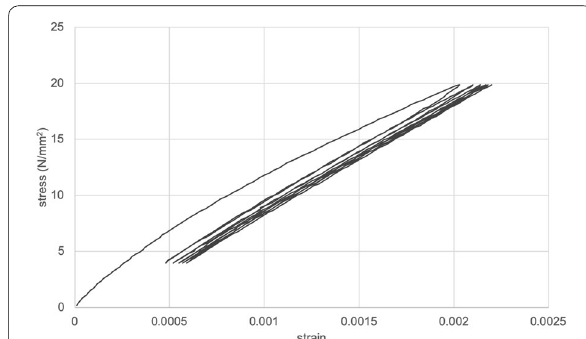
Fig. 6 Typical experimental stress–strain curve for elastic